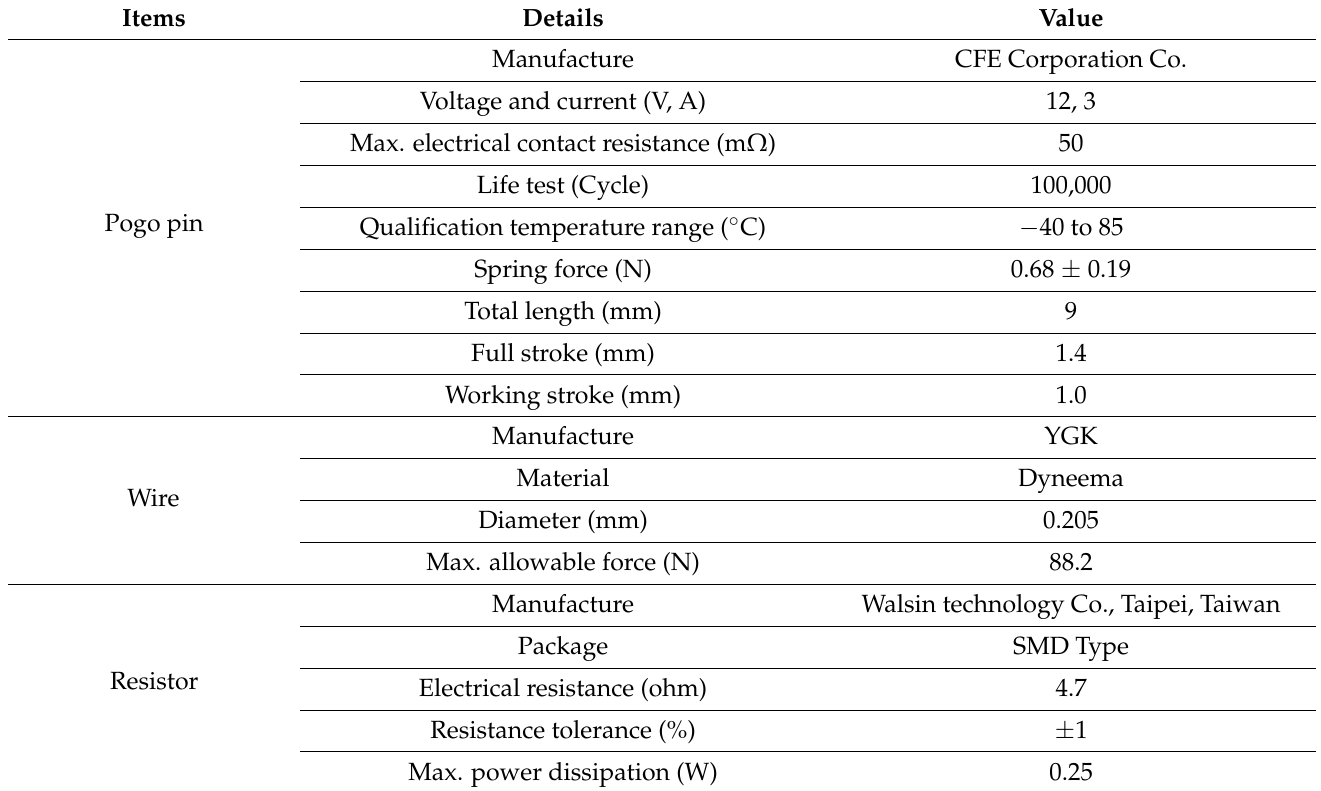
Figure 6a,b illustrate the electrical system of the three-pogo pin-based